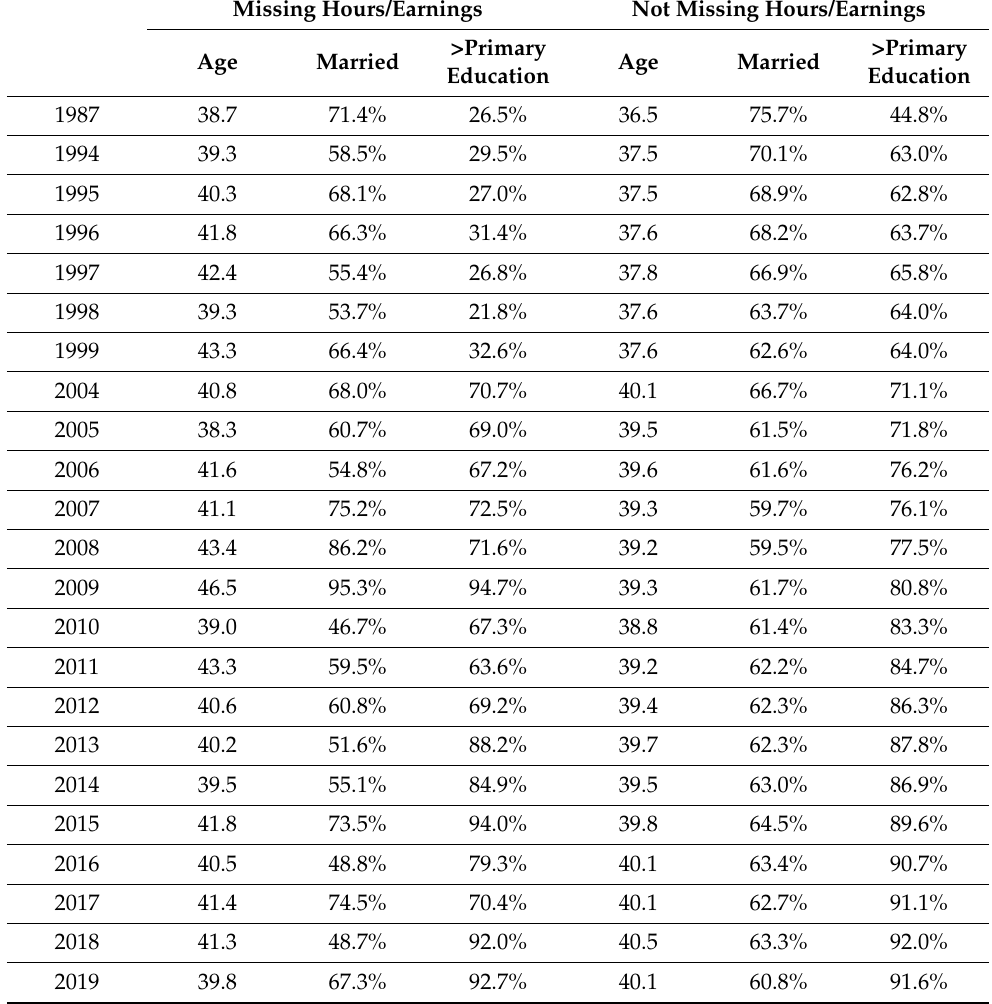
Table A2. Characteristics of sample by whether missing information on hours/earnings, over time.